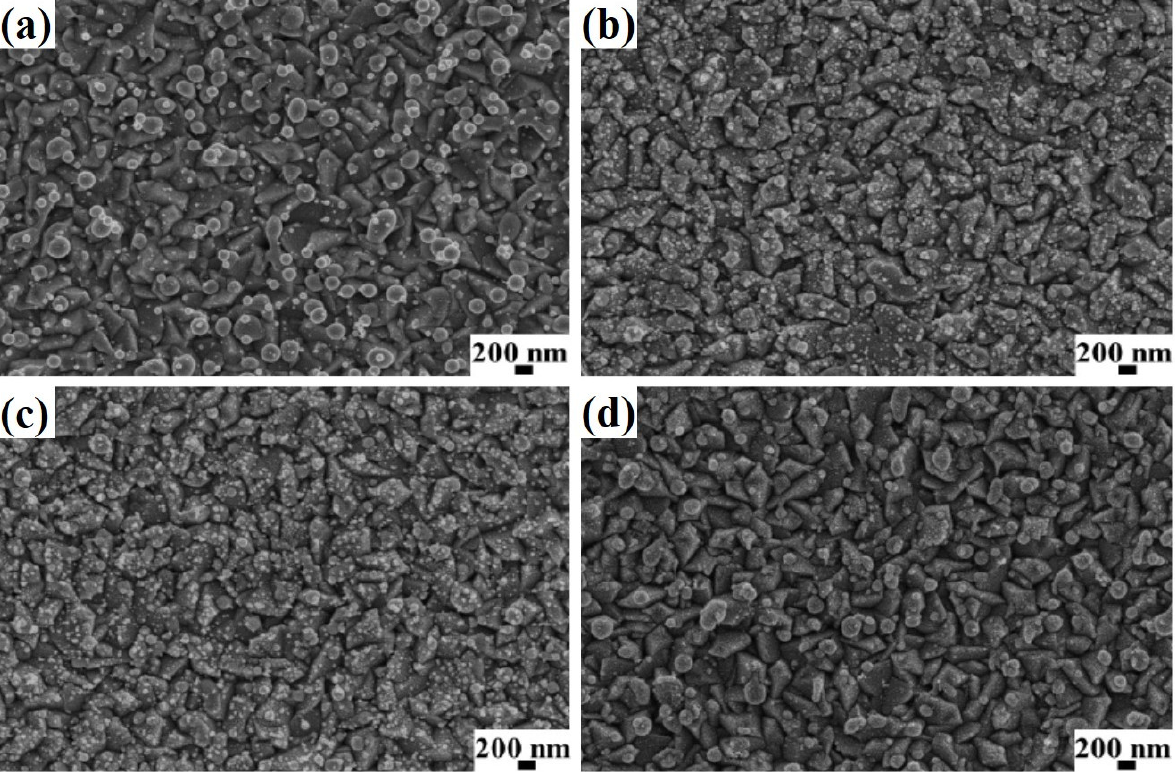
Figure 2. SEM images of FTO surface covered by 17.6- nm-thick Pd film and laser irradiated at the fluence values ( a ) 0.50 J/cm 2 , ( b ) 0.75 J/cm 2 , ( c ) 1.00 J/cm 2 and ( d ) 1.50 J/cm 2 .